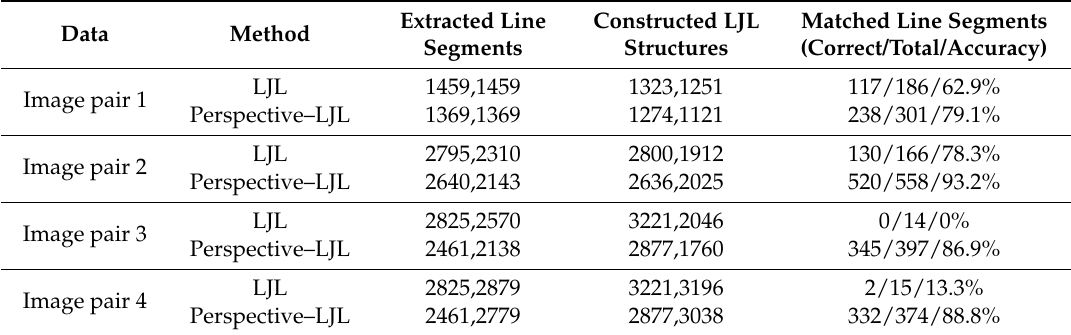
Table 3. The comparison of line matching amongst the four pairs of original and rectified